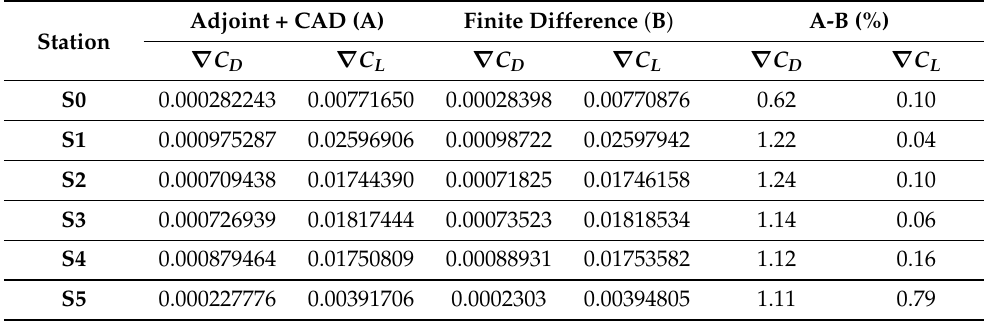
Table 2. Validation of performance gradients computed using adjoint + CAD and finite difference.